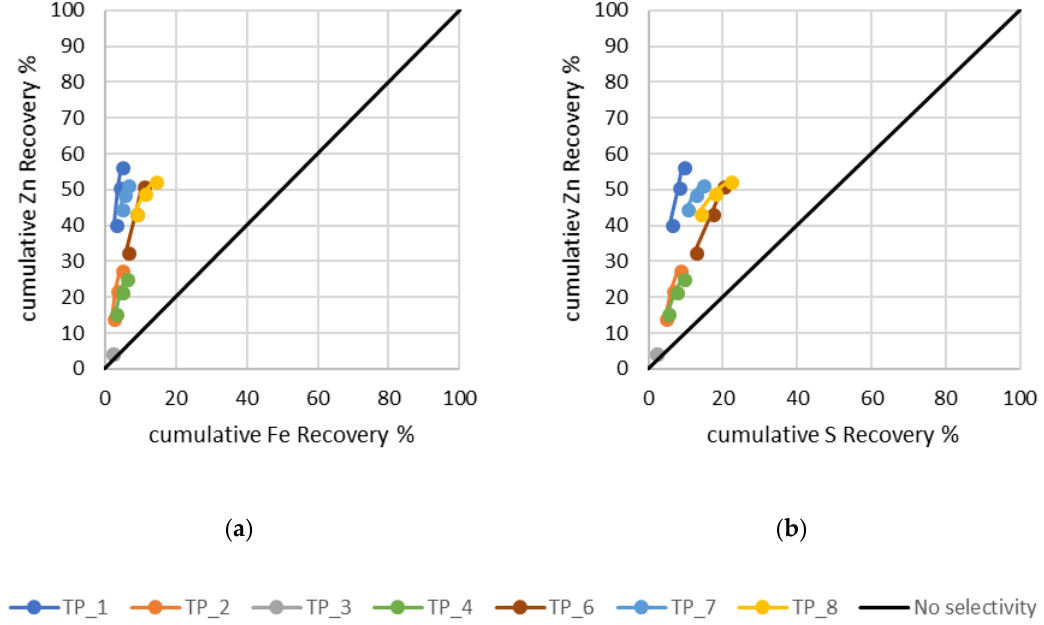
Figure 4. Fuerstenau plots of the flotation tests displaying cumulative Zn recovery to cumulative Fe recovery ( a ) and cumulative Zn recovery to cumulative S recovery ( b